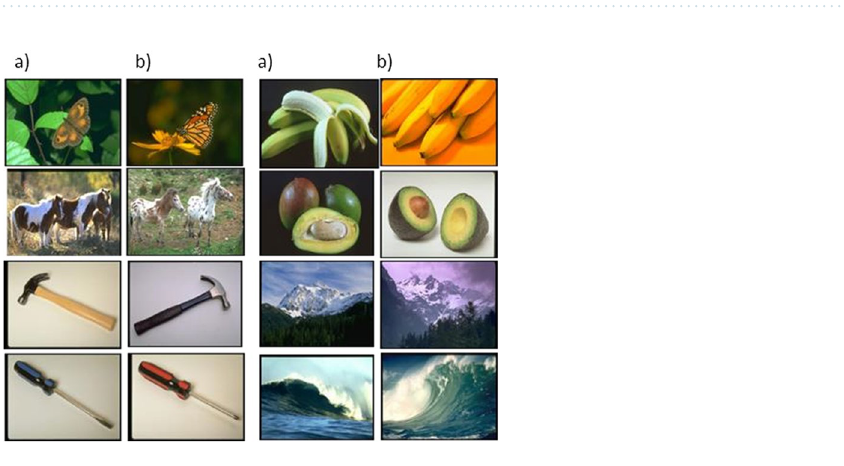
Figure 2. Examples of images used for the exemplar condition. For example, the images ( a ) were presented during the learning phase and the images ( b ) during the testing phase. The images came from the CerCo lab’s collection of